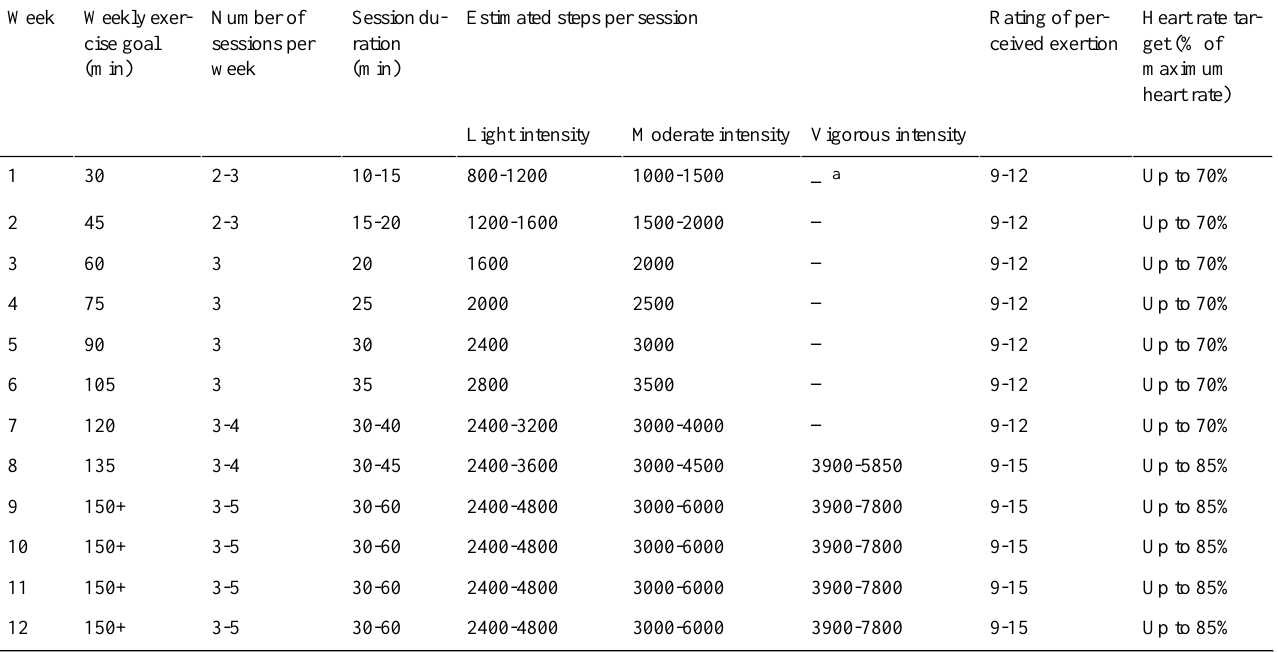
Table 2. Fit2ThriveMB exercise